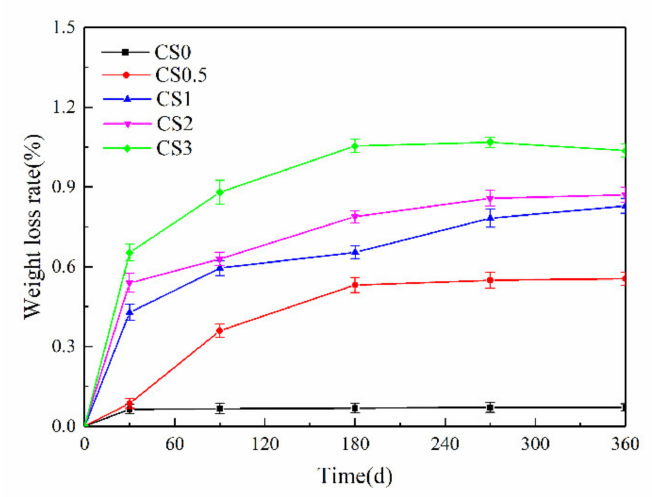
Figure 3. The changes of specimen weight versus time in different